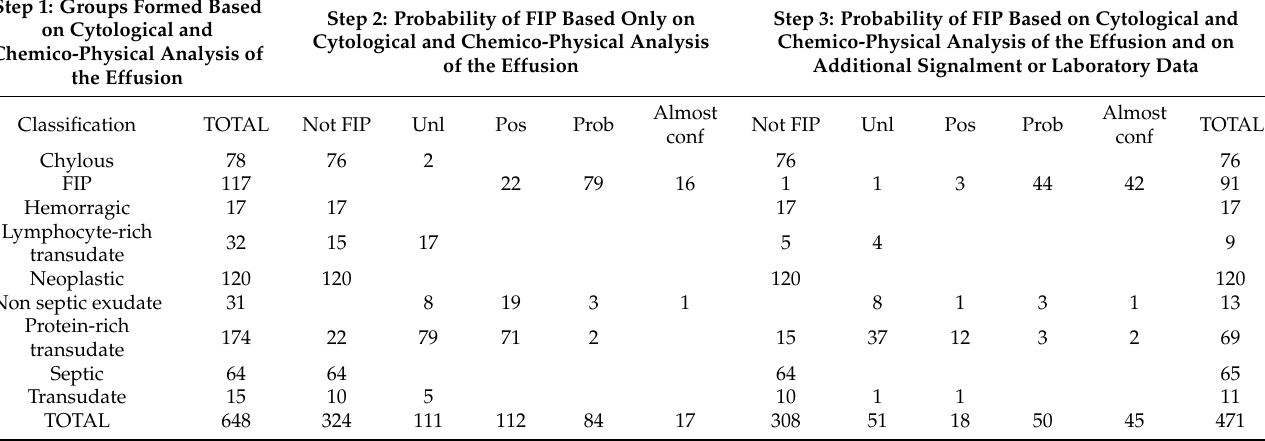
Table 3. Classification and distribution of